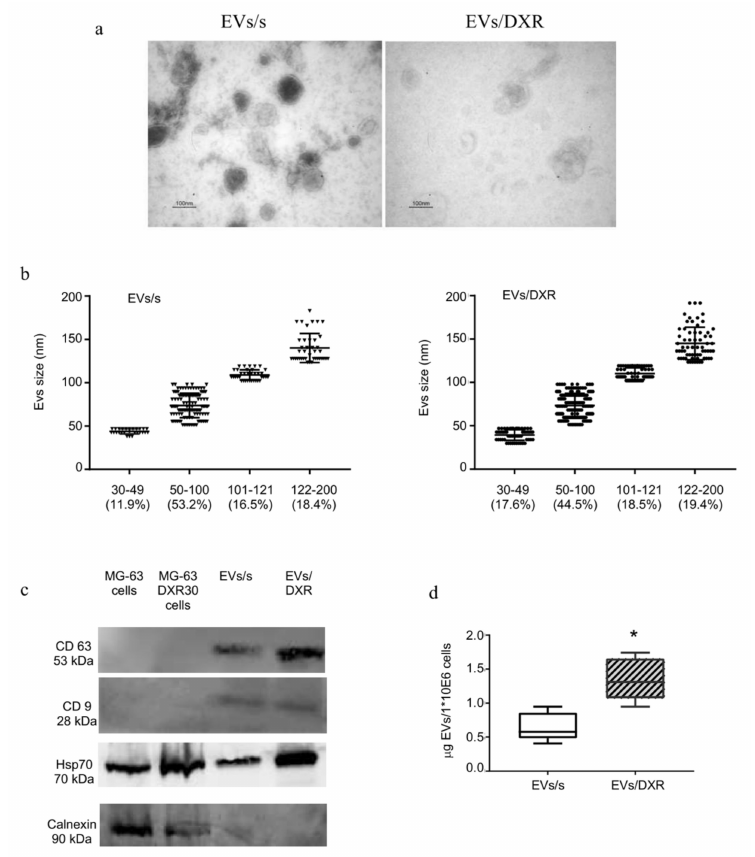
Figure 1. Osteosarcoma–derived extracellular nanovesicles (EVs) characterization. ( a ) Representative transmission electron microscopy images of EVs, isolated from medium conditioned by MG-63 (EVs/s) and MG-63DXR30 (EVs/DXR) cells (scale bar: 100 nm). ( b ) The distribution of vesicles in different size classes is described as percentage of distribution, with evidence of individual measurements, mean ± standard deviation. ( c ) Protein content-based EVs characterization was assessed by Western blot analysis for the expression of transmembrane proteins, cytosolic protein, and endoplasmic reticulum protein. ( d ) Box-plots depicting the release of EVs by OS cells, that was quantified by protein assay and normalized on 1 × 10 6 viable cells (median and min-max values are shown, n = 5, Mann–Whitney test, * p -value =